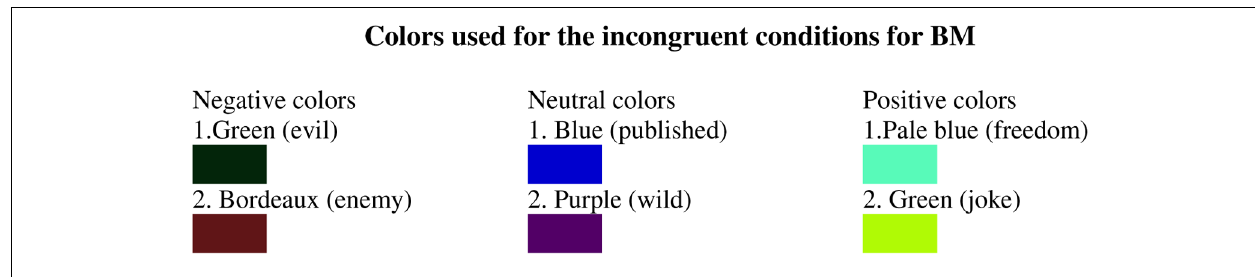
FIGURE 2 | Colors used for the incongruent conditions (i.e., negative, neutral, and positive) for BM. The word associated with the color is in parentheses.